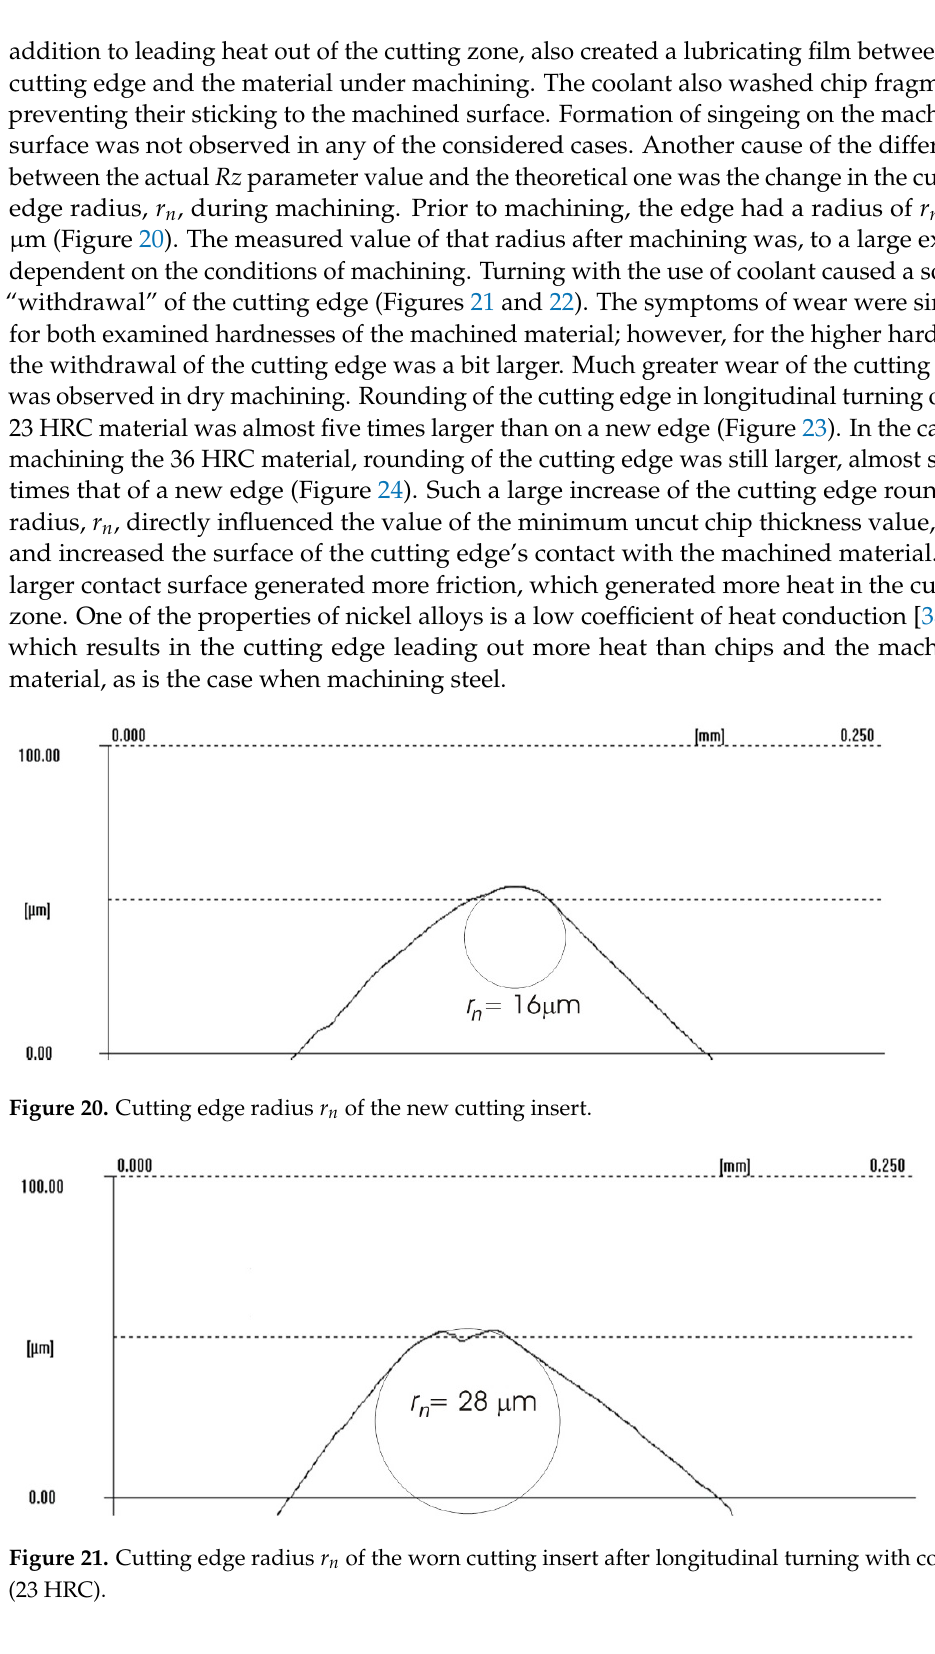
Figure 19. View of the chip shape after longitudinal turning without coolant (36 HRC).